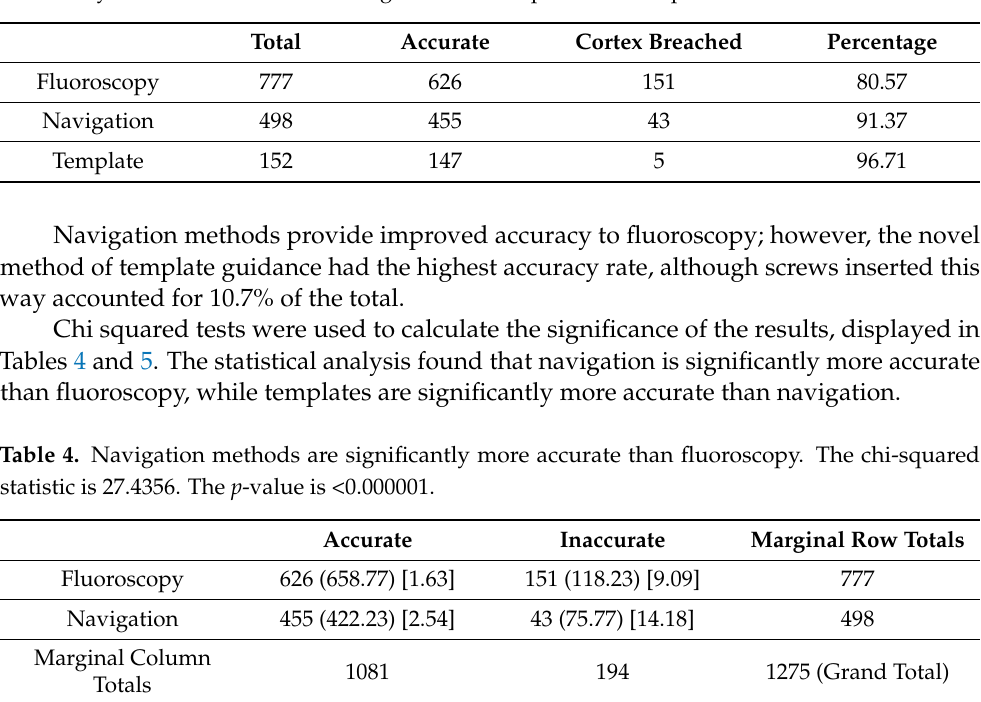
Table 3. Synthesis of all trials according to method of pedicle screw placement.